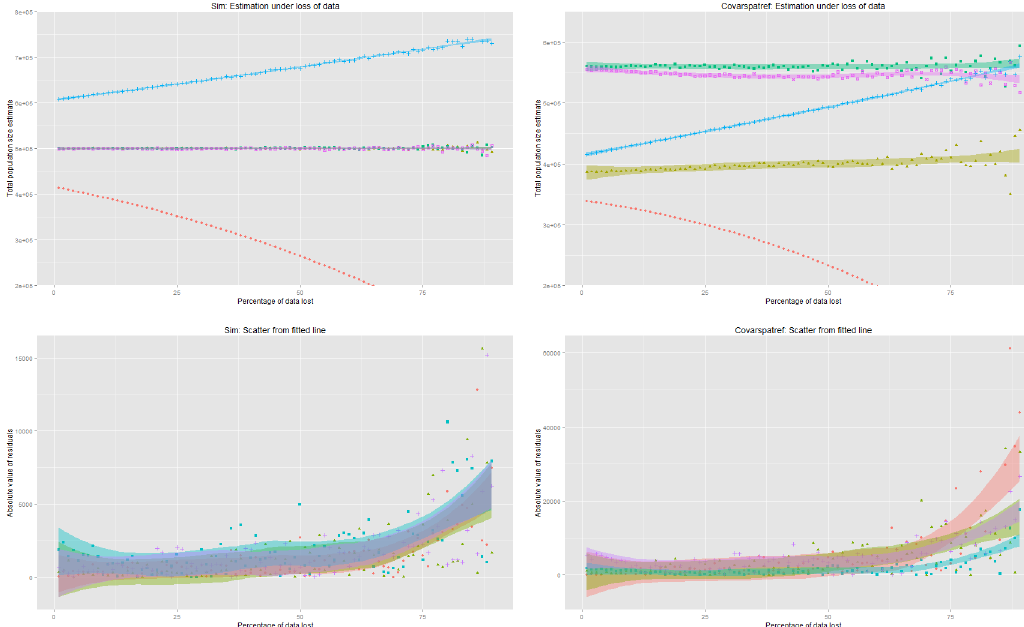
red) under random, increasing loss of data.